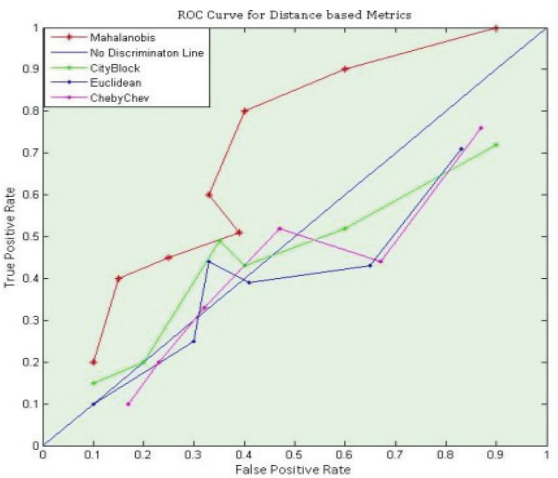
Fig. 20. ROC curve for distance based classifier